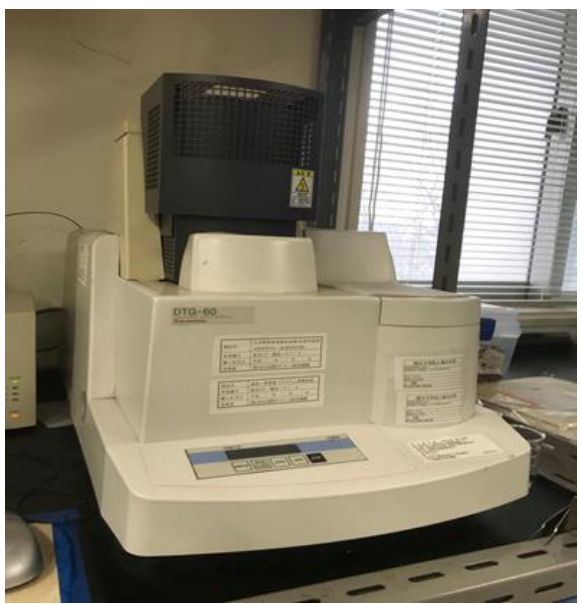
Figure 2. Framework for this study.